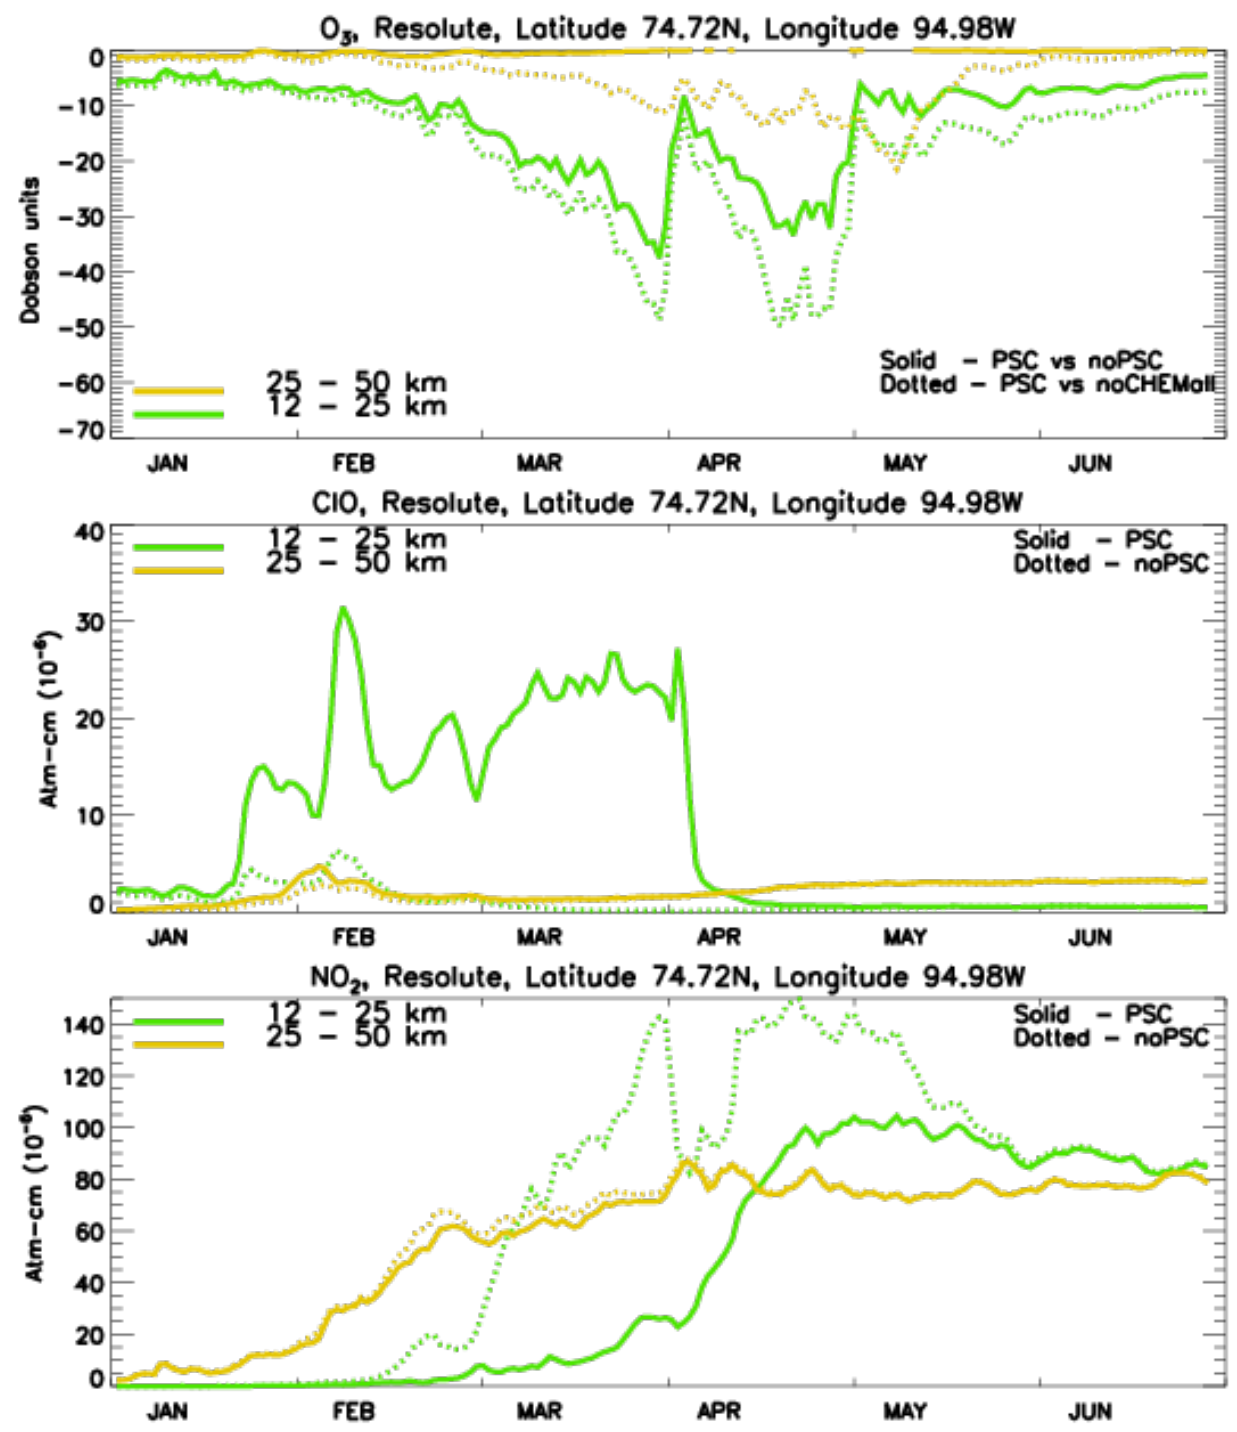
Figure 17. Resolute station values estimated with the CTM for the lower stratosphere (green) and the upper stratosphere (yellow): ( top ), the difference in ozone content for the scenarios PSC and noPSC (solid) and PSC, and PSC and noCHEM (dotted), chlorine monoxide ( middle ), and nitrogen dioxide ( bottom ) for the PSC (solid) and noPSC (dots).